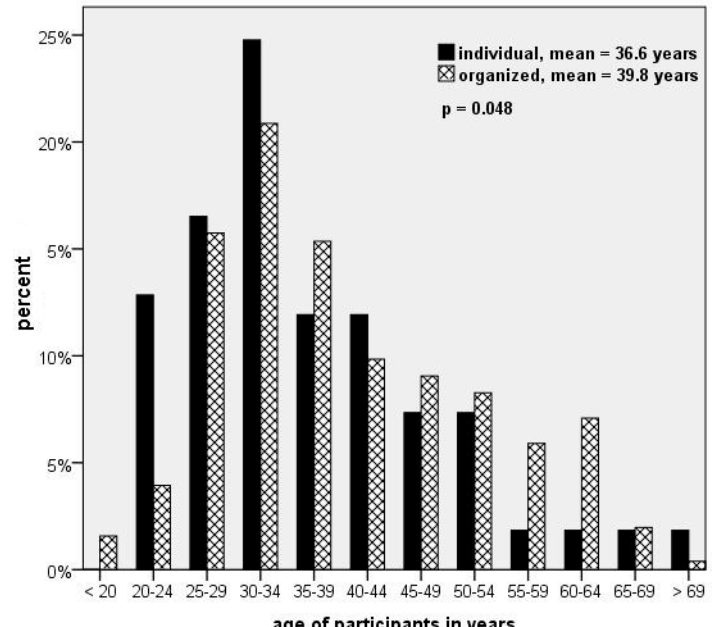
Figure 1. Age of the participants and mode of travel.